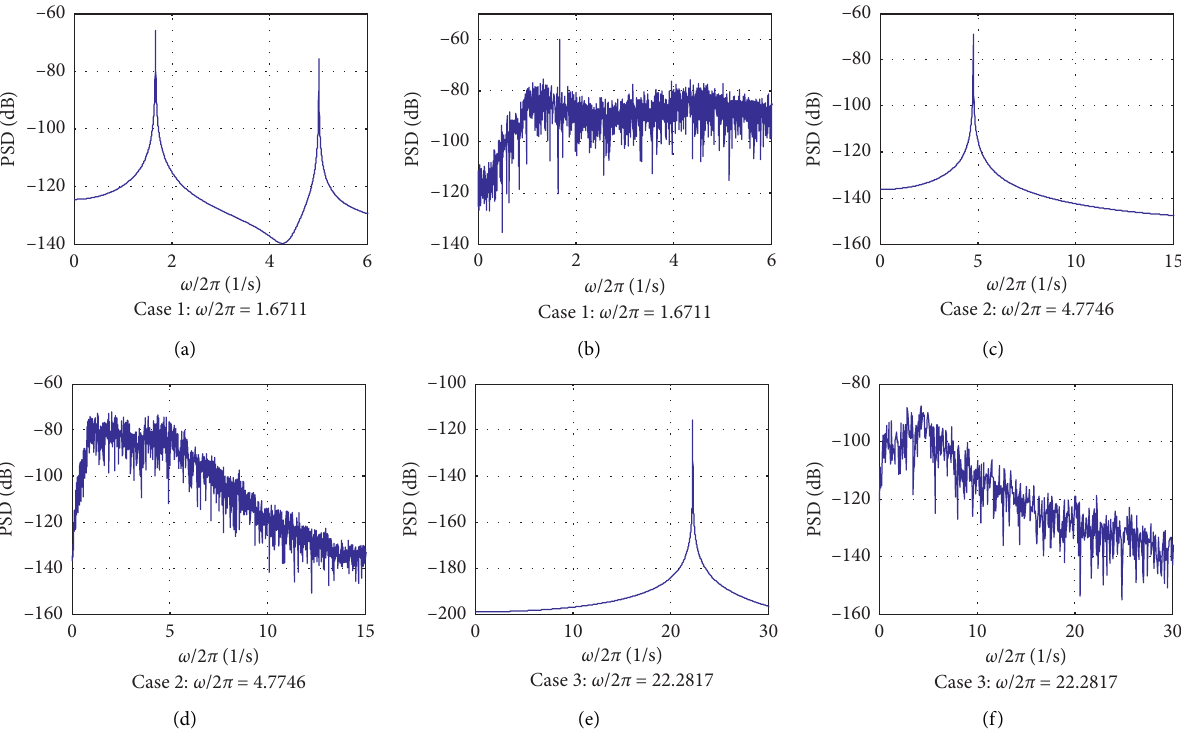
Figure 11: Profiles of power spectral densities of the QZS system response transmitted to the base without control (the 1 st row) and with control (the 2 nd row) at different excitation frequencies.